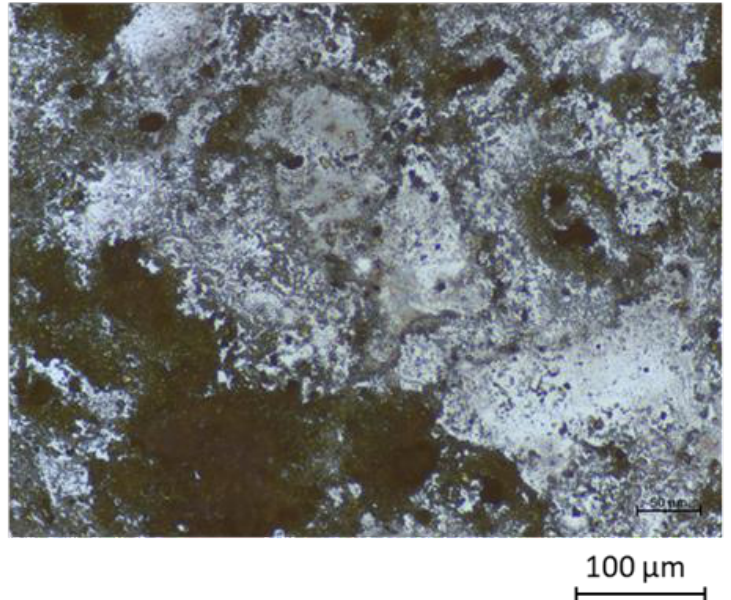
Figure 8. Microscope images of Na-Pery.